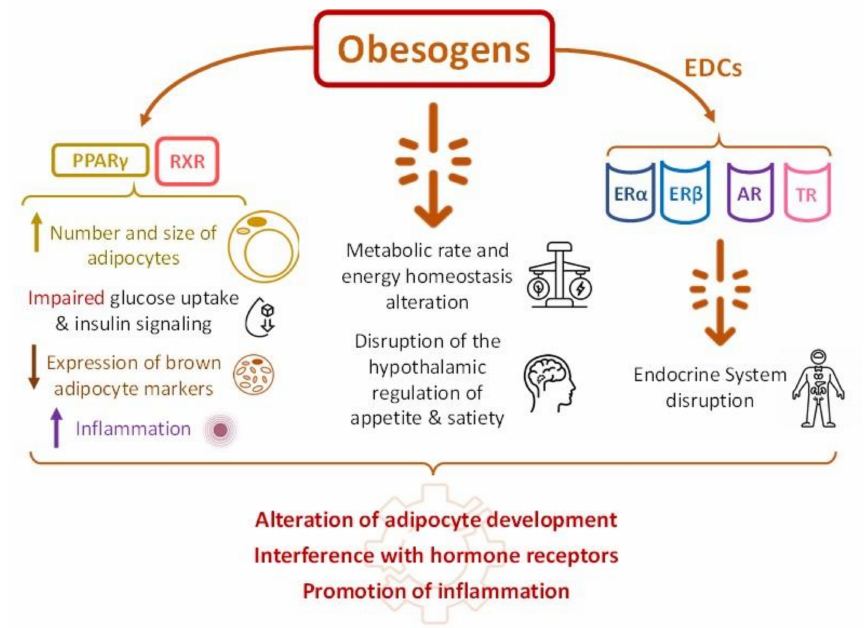
Figure 1. Mechanisms mediating the health-disruption effects of obesogens and the corresponding alterations provoked. AR, androgen receptor; EDCs, endocrine disrupting chemicals; ER α , estrogen receptor alpha; ER β , estrogen receptor beta; PPAR γ , proliferator-activated receptor gamma; RXR, 9-cis receptor retinoic acid; and TR, thyroid hormone